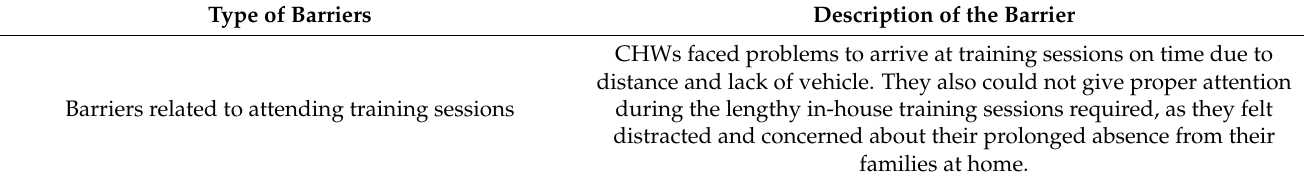
Table 4. Summary of difficulties to implement the integrated child development intervention identified by community health workers and their supervisors. Type of